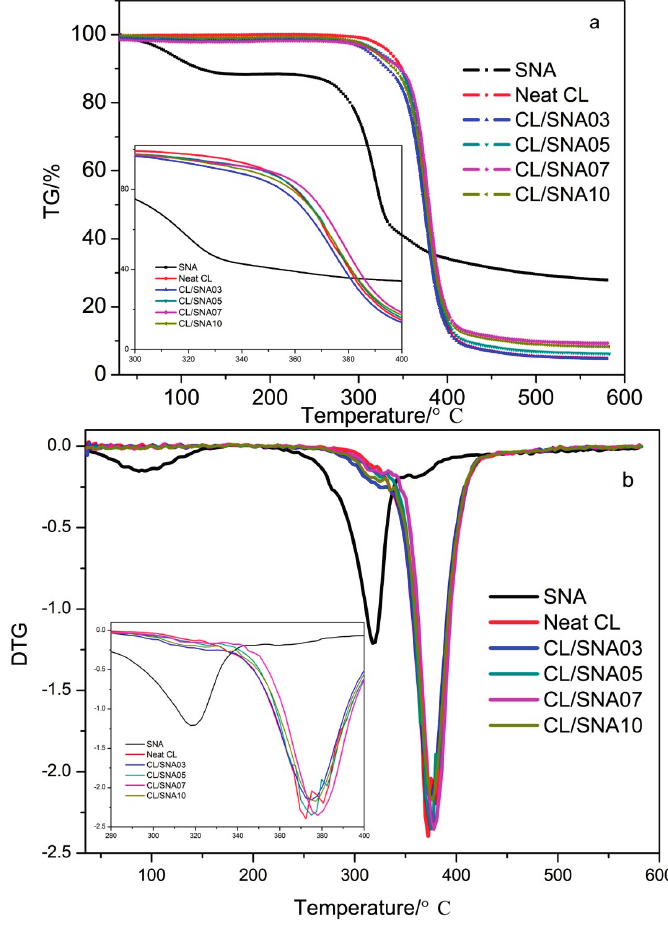
Figure 5. TG ( a ) and DTG ( b ) of CL/SNA, SNA, and